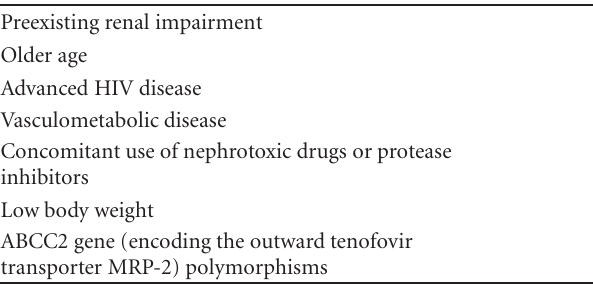
Table 3: Predictors of significant renal function